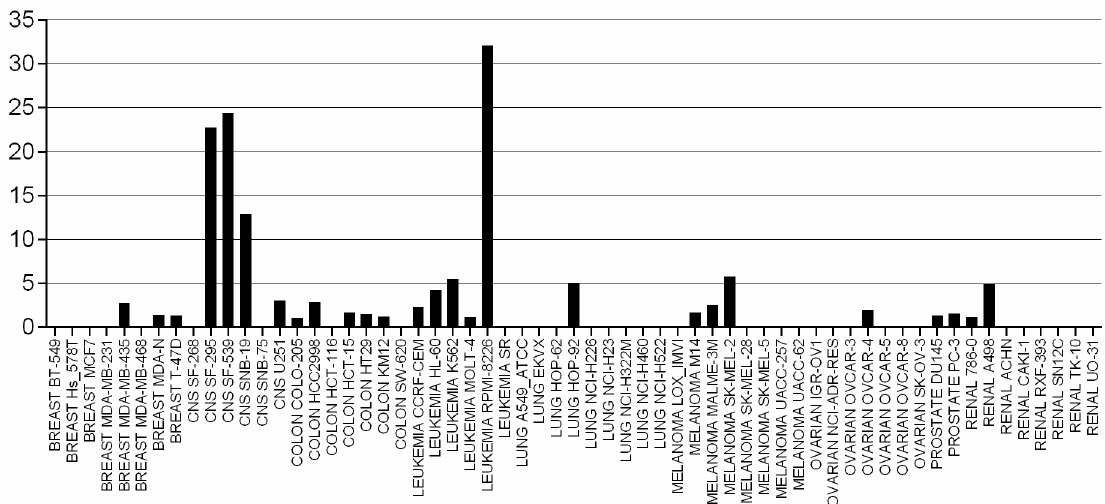
Fig 1. Percent of P. acnes HL096PA1 genes identified. The percent of genes identified out of 2,175 for P. acnes HL096PA1 (NC_021085.1) across all 61 NCI-60 datasets. A gene was considered identified if one or more reads (32-base long subsequences) mapped with no genomic variation (zero mismatch).